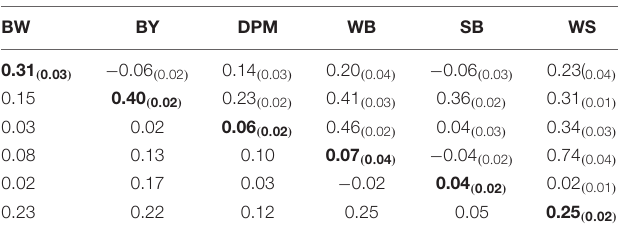
TABLE 5 | Genetic parameter results for study